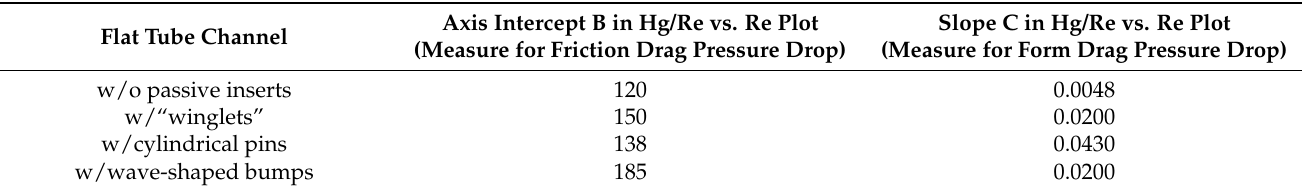
Table 5. Measures (slope C and axis intercept B from Hg/Re vs Re plot) for friction B and form C drag pressure